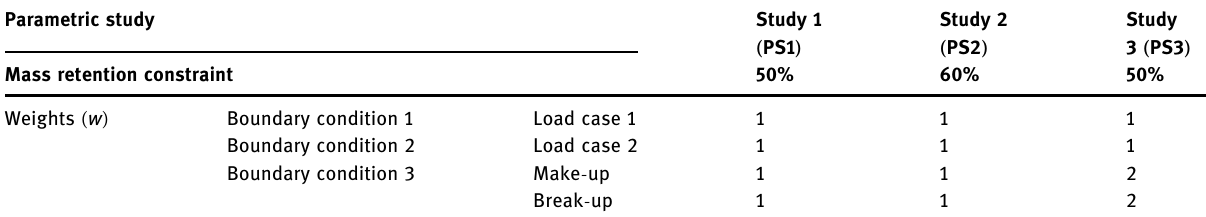
Table 4: Analysis settings for PS within topology optimization Parametric